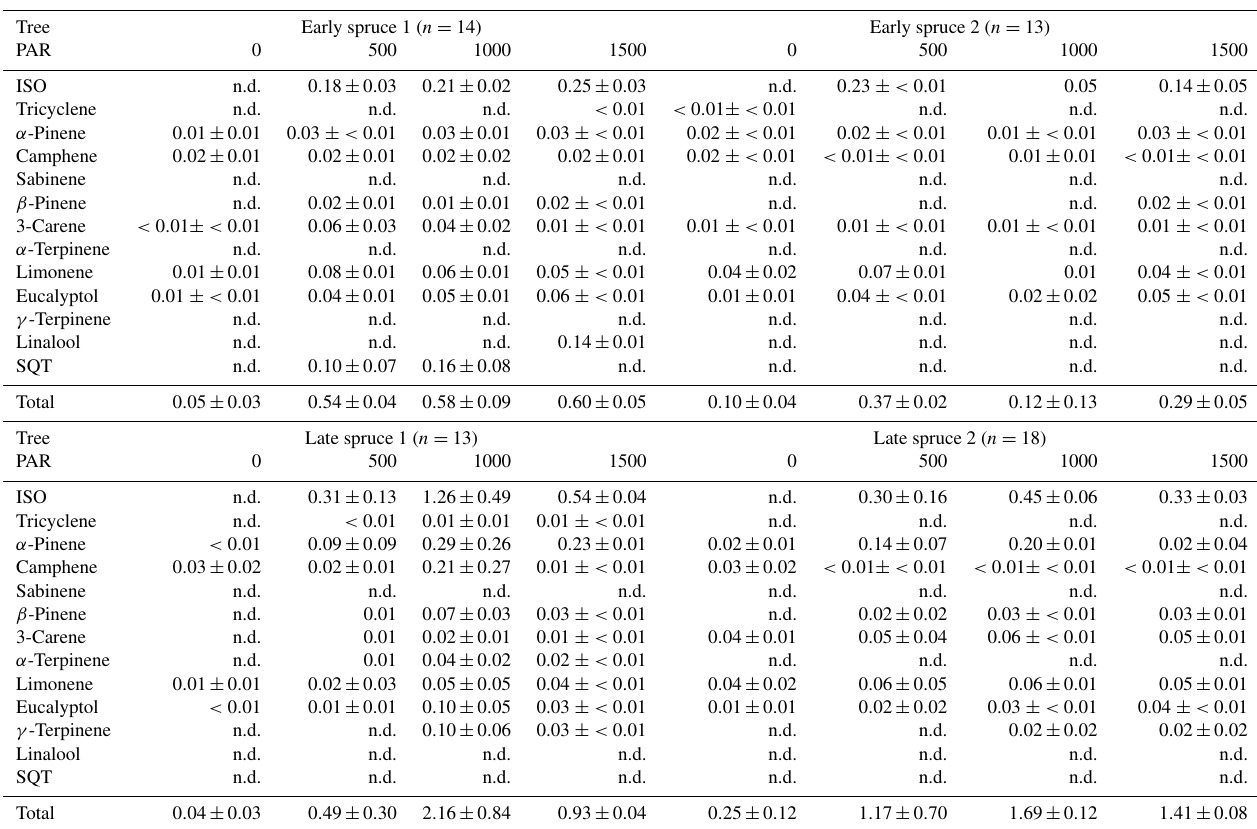
Table A3. The mean average actual emission ( ± SD) of detected compounds at light levels (PAR) 0, 500, 1000 and 1500µmolm − 2 s − 1 and the number of samples taken from the two provenances of spruce ( Picea abies ) in µggdw 1 h − 1 . No data (n.d.) indicates that the compound was not detected in any sample for the measured light level on that particular tree.